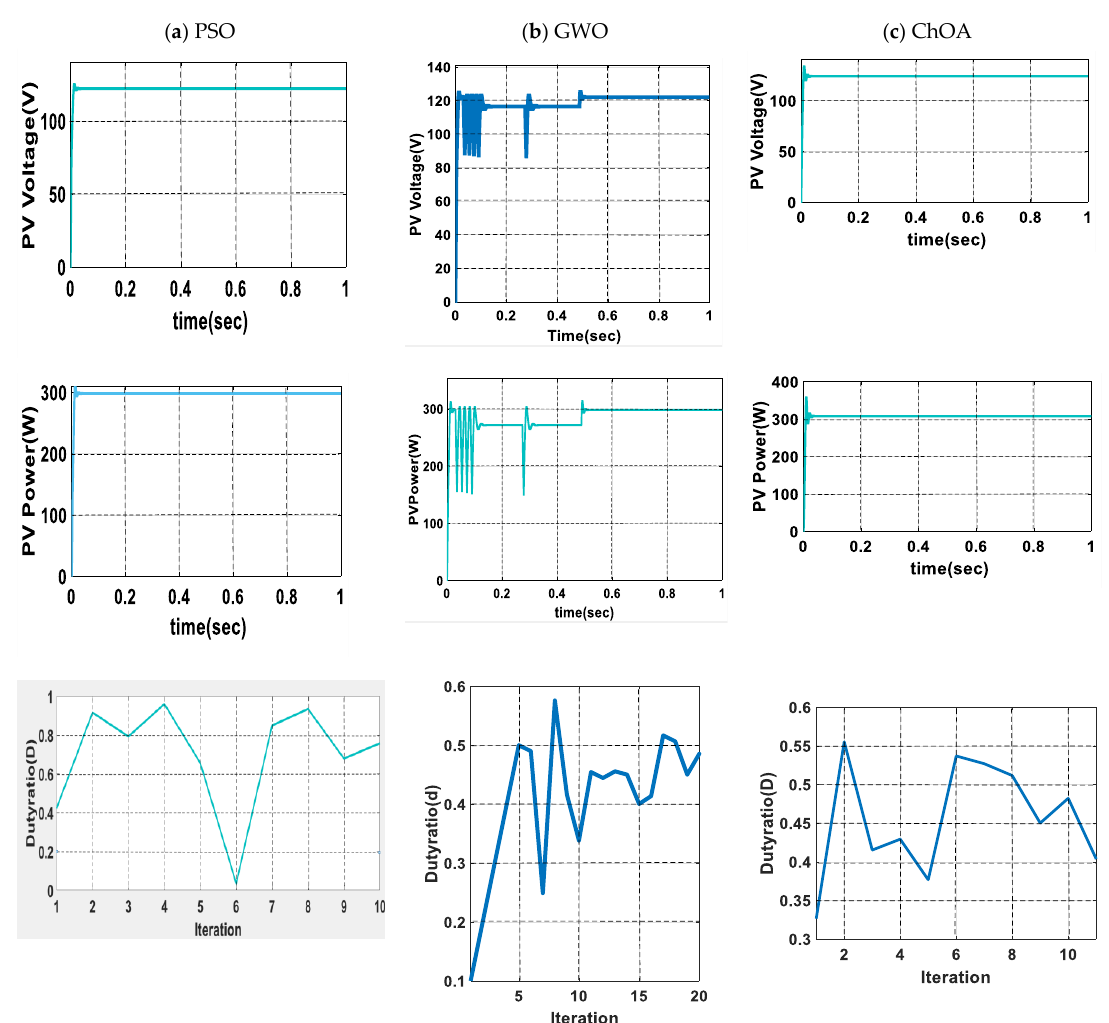
Figure 14. Precise Simulation results of PV strings for shading pattern of 1000 W/m 2 , 1000 W/m 2 , 500 W/m 2 , 500 W/m 2 proposed technique, PSO and the conventional P&O technique for weak shading pattern: ( a ) PSO technique ( b ) GWO technique ( c ) ChOA technique.